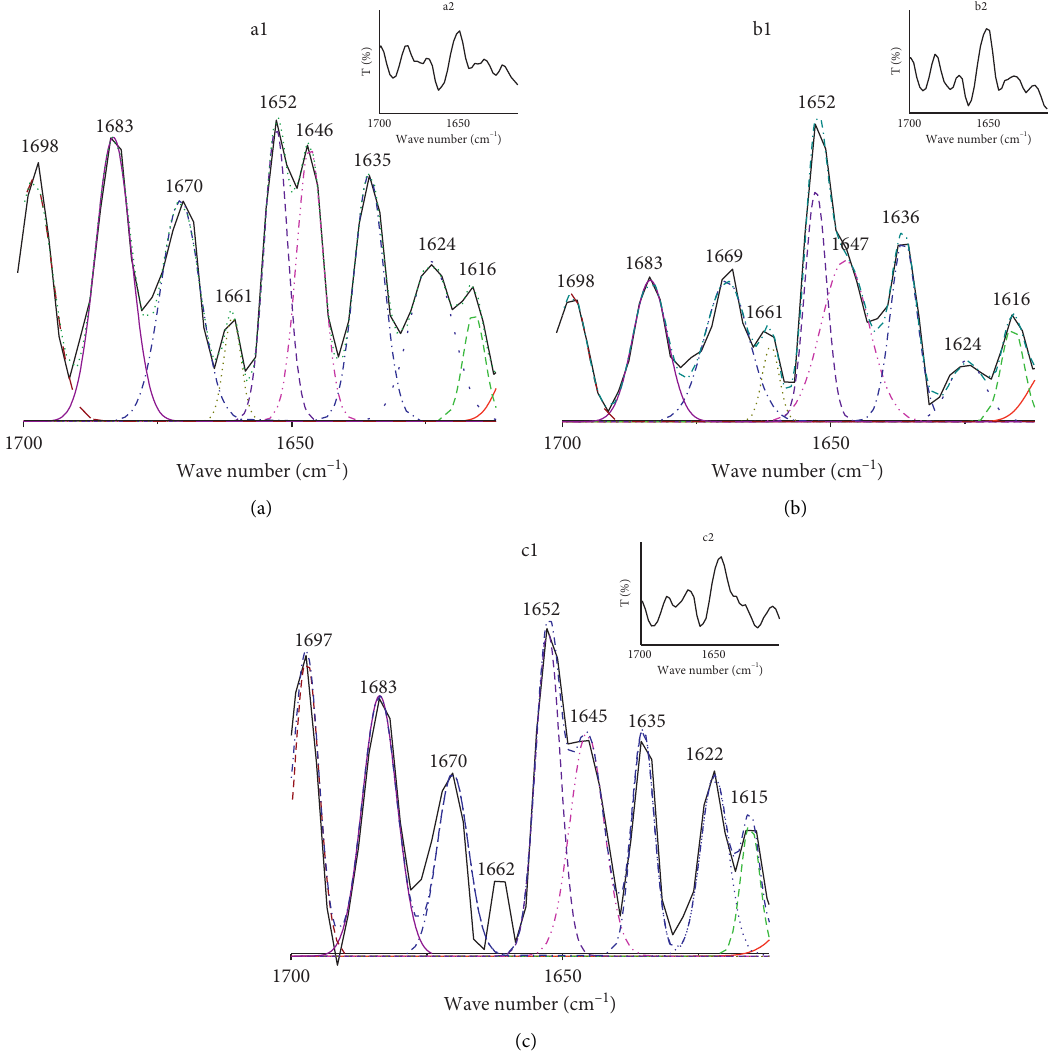
Figure 6: ATR-FTIR curve-fitting spectra of LYSO (a1), (luteolin-LYSO)-luteolin (b1) and (luteoloside-LYSO)-luteoloside (c1), and differential spectra of LYSO (a2), (luteolin-LYSO)-luteolin (b2), and (luteoloside-LYSO)-luteoloside (c2), when T � 298K.